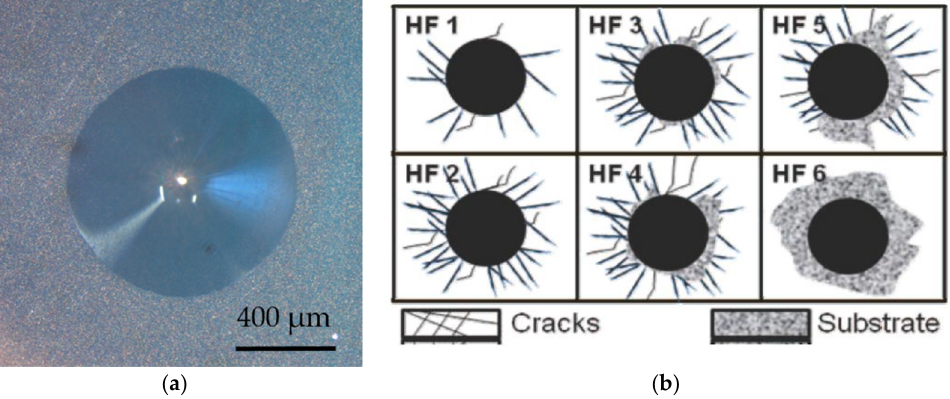
Figure 6. Daimler–Benz Rockwell-C adhesion test: ( a ) indentation of an STF35 film produced by DPAD; ( b ) test chart of different adhesive strengths according to [20,21]. Reprinted with permission from Elsevier.